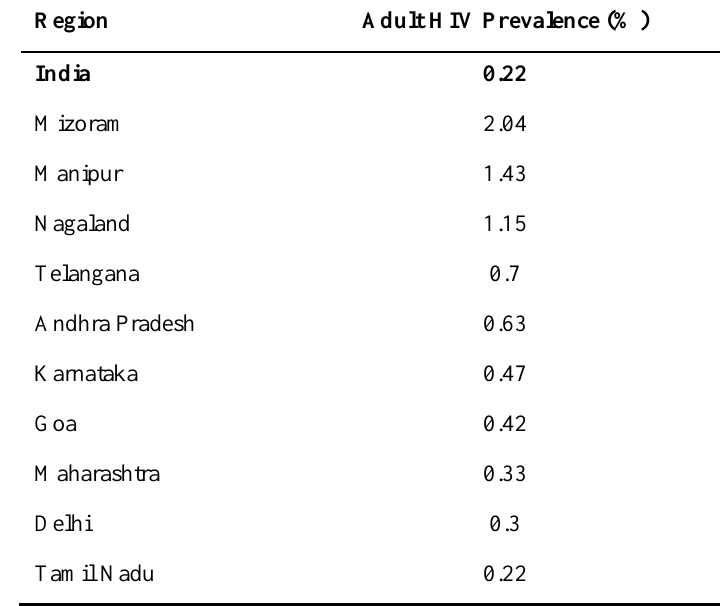
Table 1. States with Adult (15-49 years) HIV Prevalence about the National Average, 2017 ART, to manage